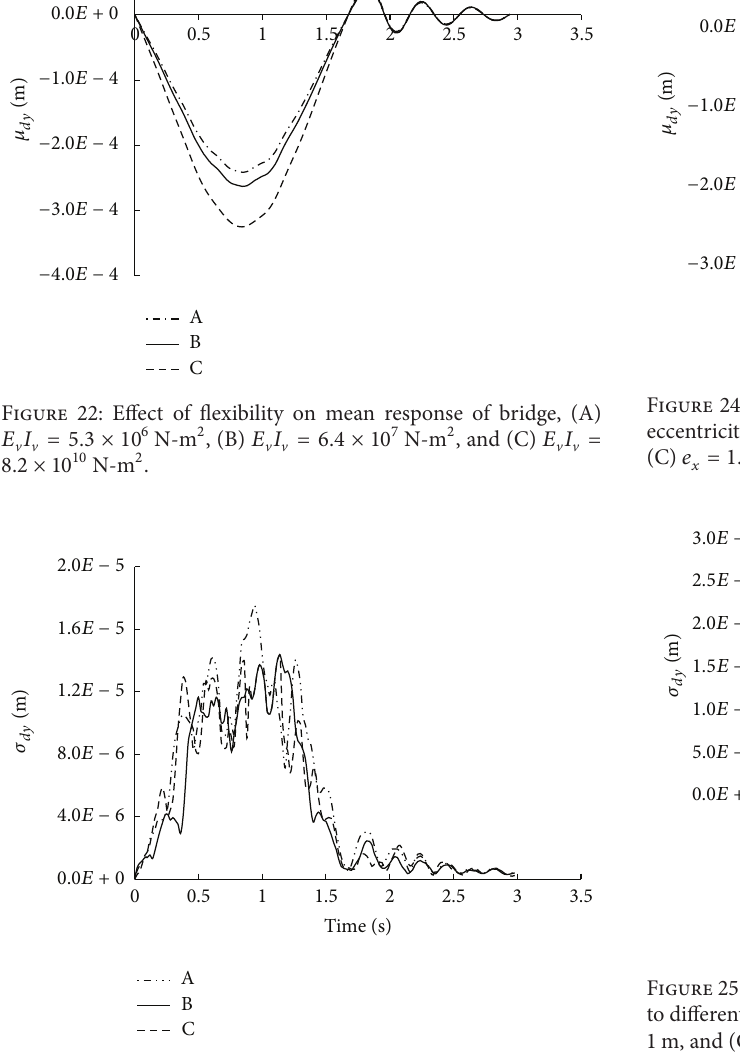
Figure 23: Effect of flexibility on standard deviation of bridge response, (A) 𝐸 V 𝐼 V = 5.3 × 10 6 N-m 2 , (B) 𝐸 V 𝐼 V = 6.4 × 10 7 N-m 2 , and (C) 𝐸 V 𝐼 V = 8.2 × 10 10 N-m 2 .